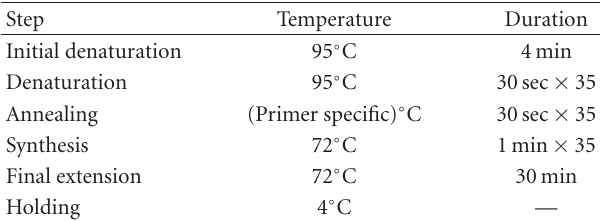
Table 4: PCR conditions for the methylated/unmethylated